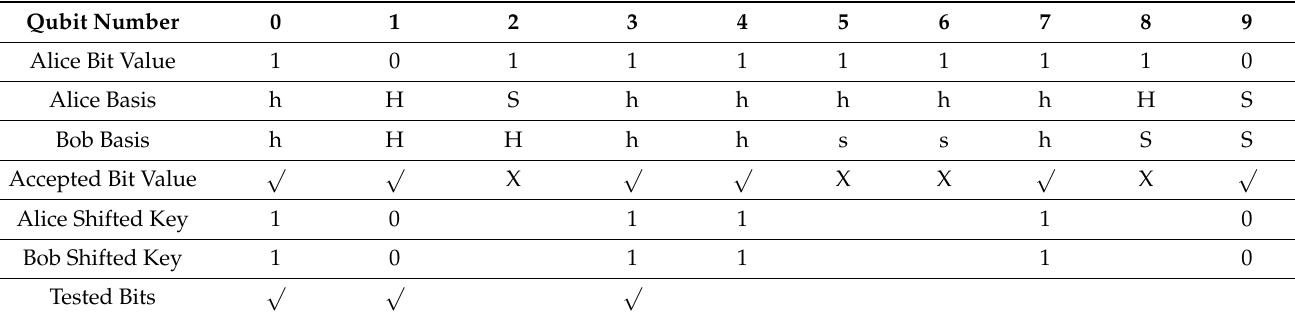
Table 6. Simulation of the BB84 protocol with 10 qubits.